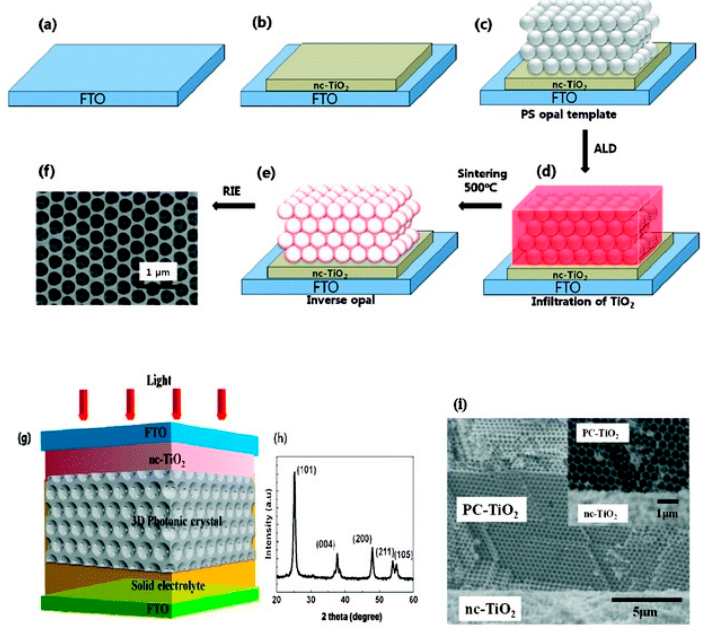
Figure 16. Schematic of procedure for preparing FTO/nc-TiO 2 /PC-TiO 2 electrodes ( a – e ); ( f ) SEM image of the top of the TiO 2 inverse opal layer; ( g ) cell configuration; ( h ) XRD pattern for TiO 2 inverse opal; and ( i ) cross section SEM image of FTO/nc-TiO 2 /PC-TiO 2 electrodes [136].